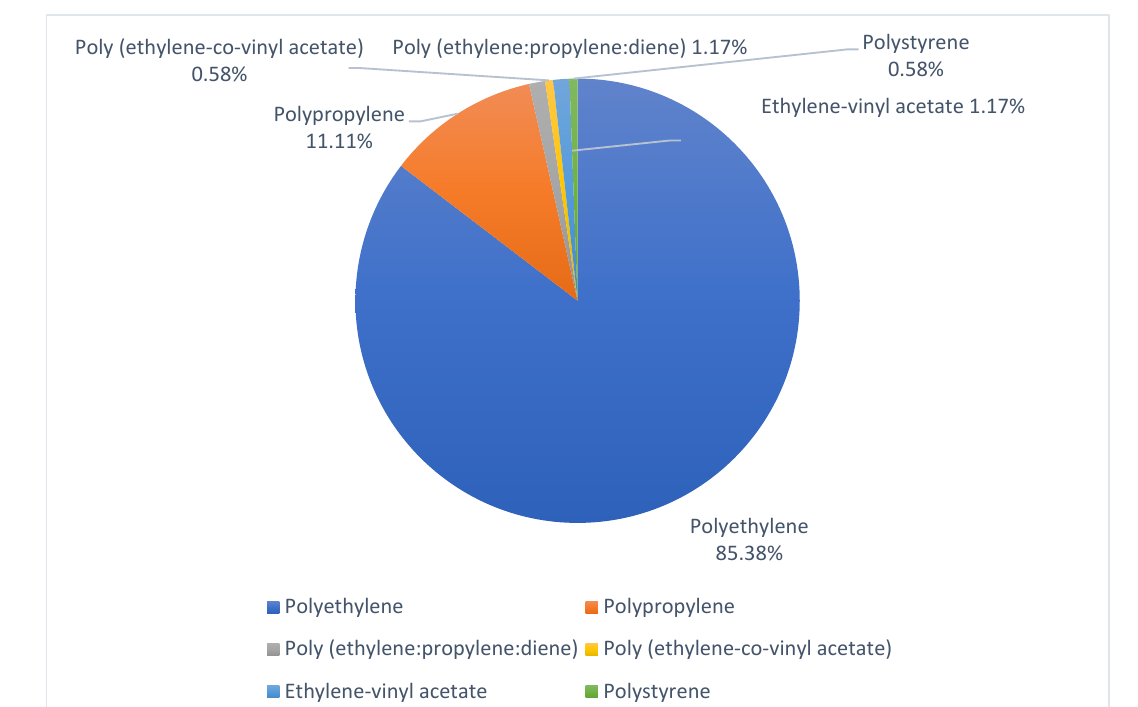
Figure 4. Chemical composition of the total MP analyzed.